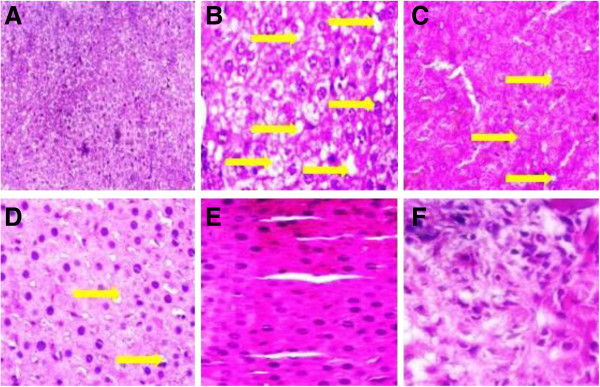
Effect of Melastoma malabathricum Linn. (MM) on liver fat accumulation in different groups of rats: (A) Normal control: (B) Diabetic control: Diabetic control histopathology of rat liver had shown the micro fat droplet deposition on round shape (yellow arrow) (C) MM I (100 mg/kg): Tested drug histopathology shown small size of fat droplet (yellow arrow) as compared to the diabetic control. (D) MM II (250 mg/kg): Tested drug histopathology shown few micro fat droplets (yellow arrow). (E) MM III (500 mg/kg): Increased tested drug treated rat histopathology similar to the glibenclamide treated group. (F) Glibenclamide (10 mg/kg): Standard drug treated group shown histopathology similar to the normal control groups. The samples were obtained from the same liver anatomical regions. For each group, 6 rats were examined and 50 pictures were taken. The above picture for each group was chosen randomly from the 80 pictures in this group. Original magnification, 40 ×.